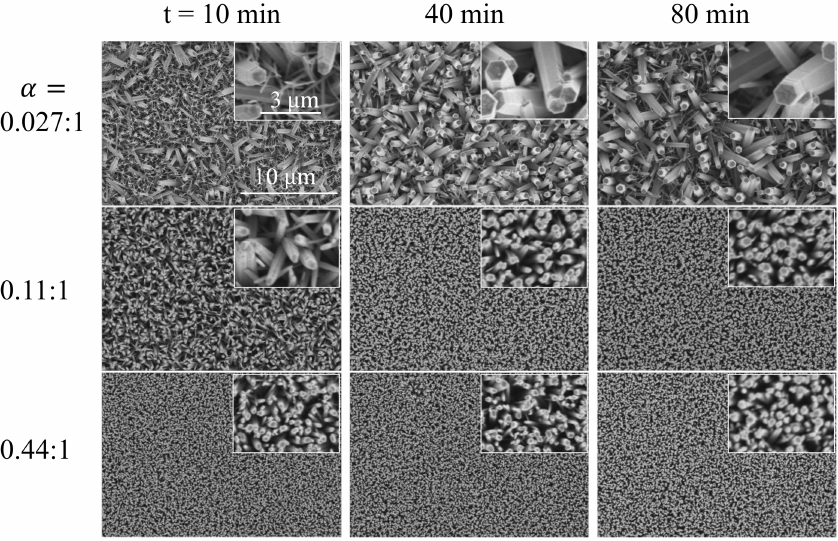
Figure 7. SEM images of nanoarrays obtained by different zinc acetate/PVA volume ratios and annealing times.